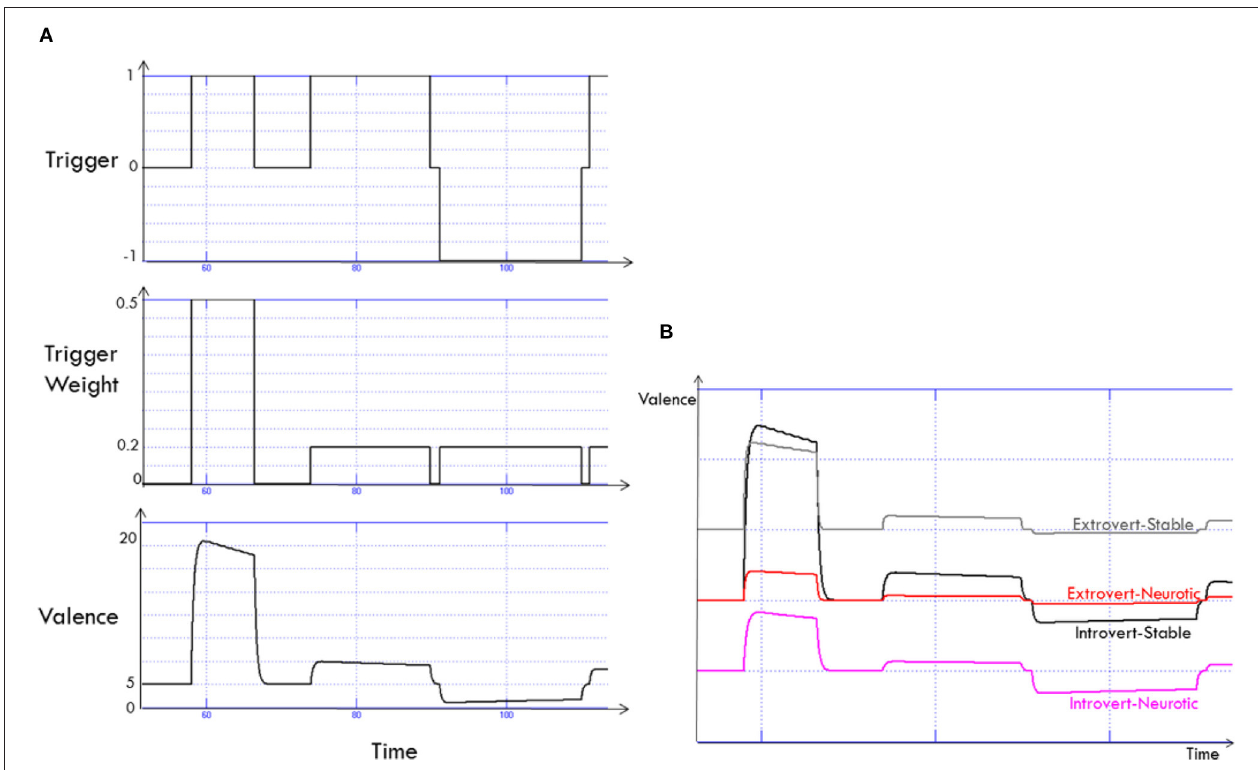
FIGURE 2 | The generation of valence over time is a function of triggers that have different weights (A) . Comparison between dynamics of the Valence for four different personality categories (B)